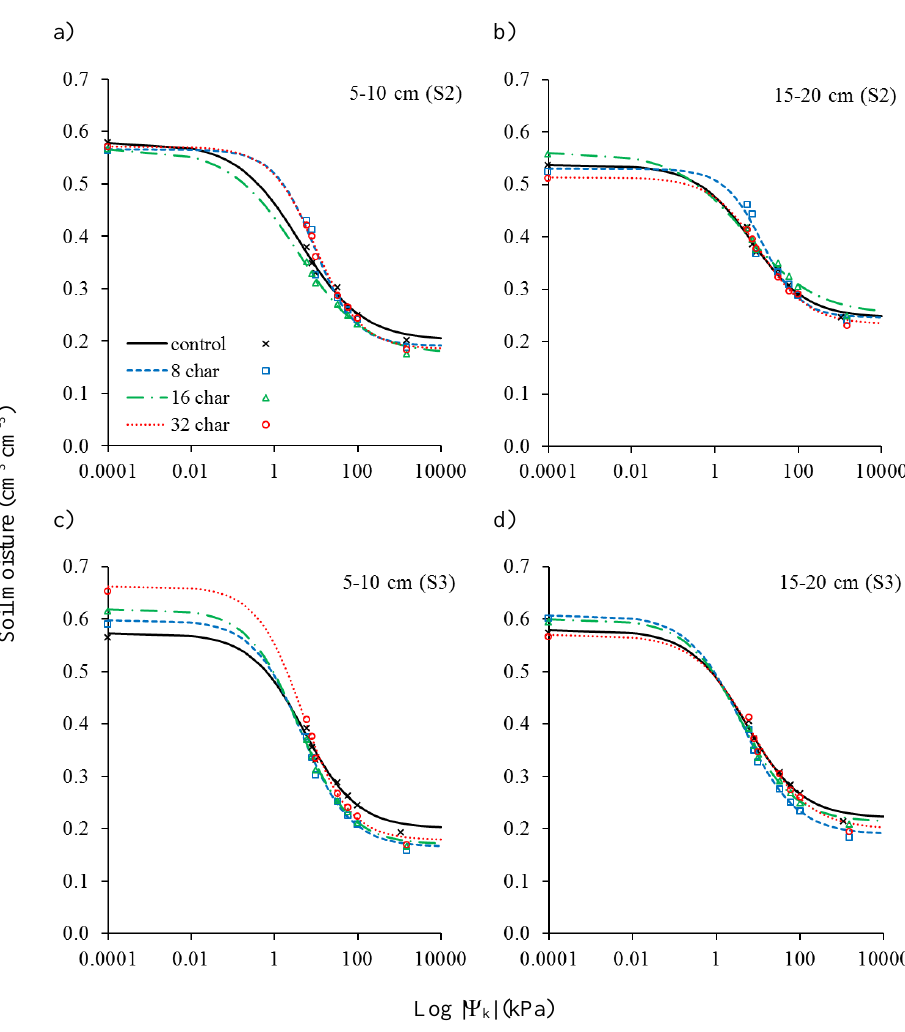
Figure 4. Predicted (lines) soil water retention curves and measured soil moisture (symbols) at a matric potential k ( k = 0, − 6, − 8, − 10, − 33, − 60, − 100 and − 1500kPa) within 5–10cm (a, c) and 15–20cm (b, d) layers obtained at two (S2 – a, b ) and three (S3 – c, d ) years after application of biochar (8, 16 and 32Mgha − 1 ) in a sandy Dystric Plinthosol. Estimates of shape parameters are presented in Table